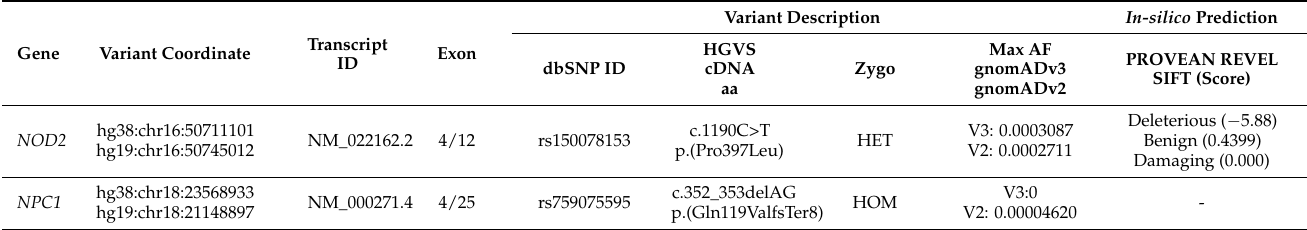
Table 2. Description of the detected